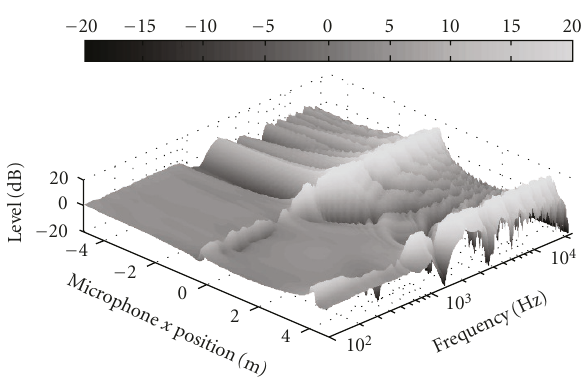
) and quality function ( q Ψ ) m m